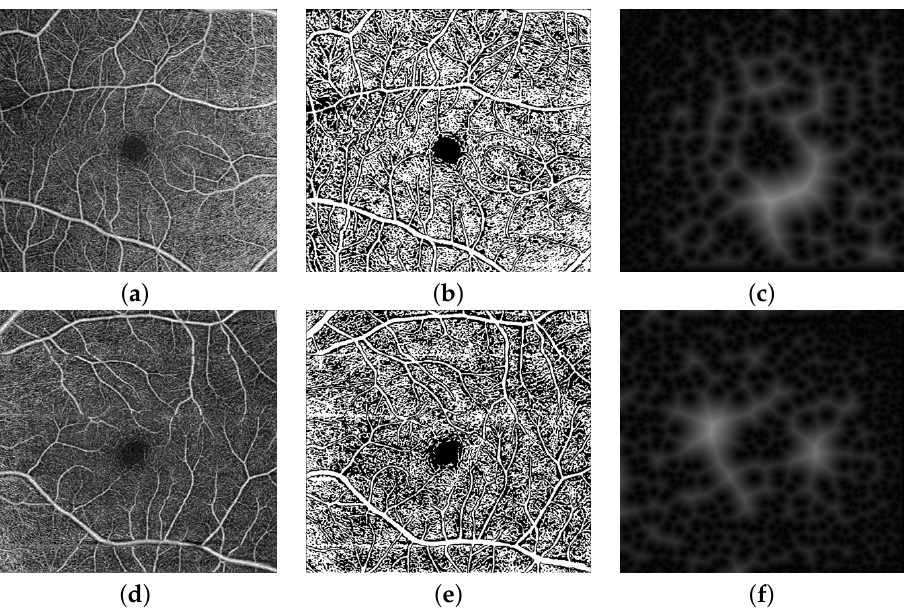
Figure 2. OCTA image example input data for DR and NDR: ( a , d ) the original superficial OCTA, ( b , e ) a binary map of the retinal vessels (RV), and ( c , f ) distance map of OCTA